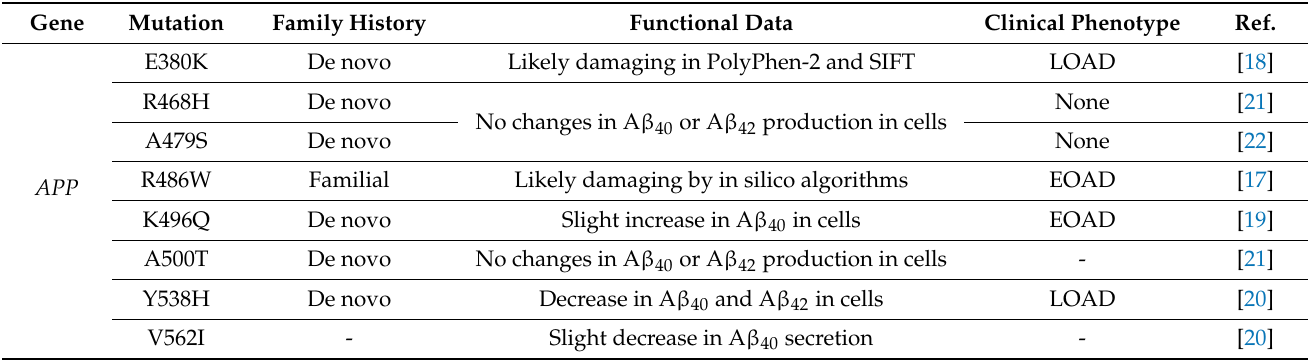
Table 1. Mutations in the E2 domain of